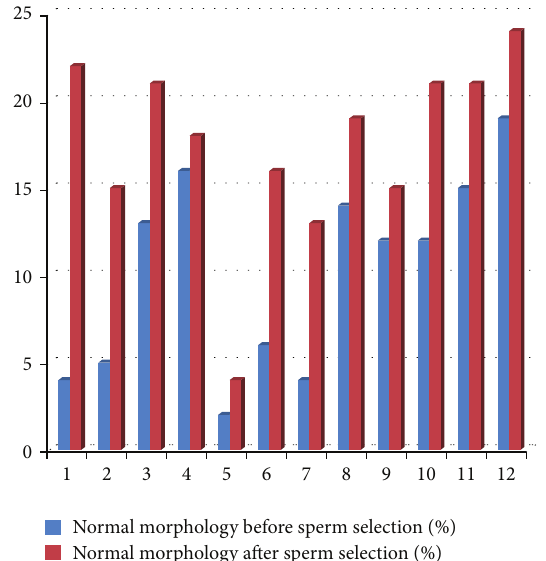
Figure5:Normalmorphologybeforeandafterspermselection( 𝑛 = 12 ).